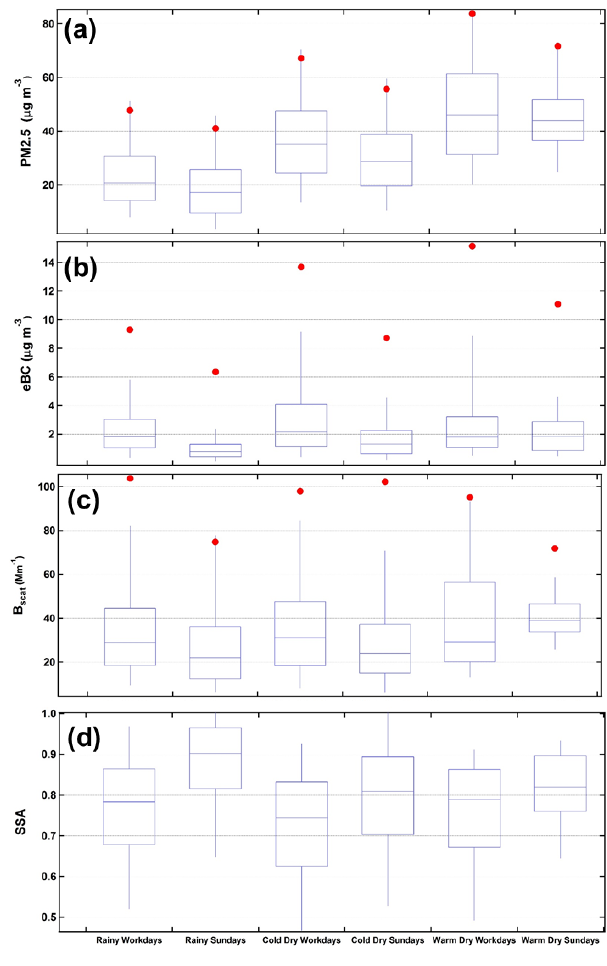
Figure 6. The same as Fig. 5 but for (a) PM 2 . 5 , (b) eBC, (c) B scat and (d)